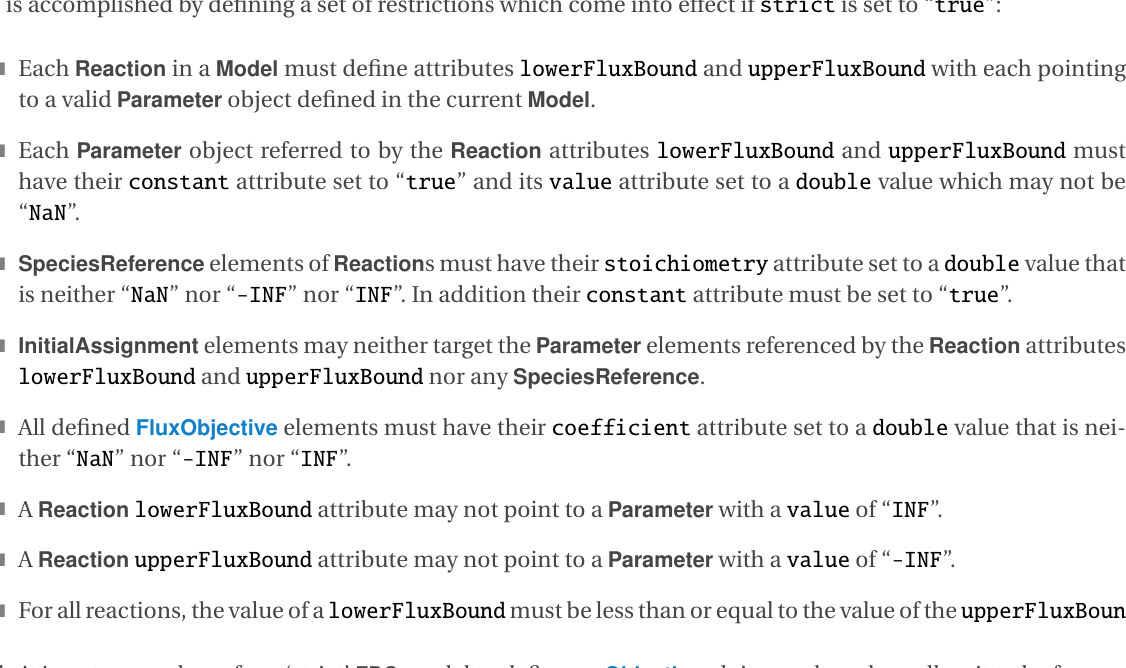
The attribute strict